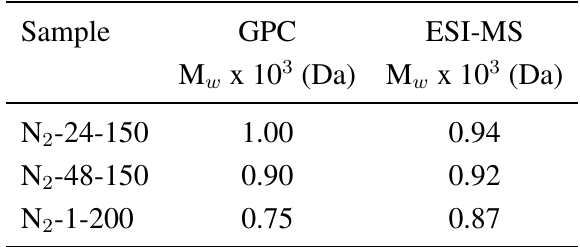
Table 3. M based on GPC and ESI-MS. w